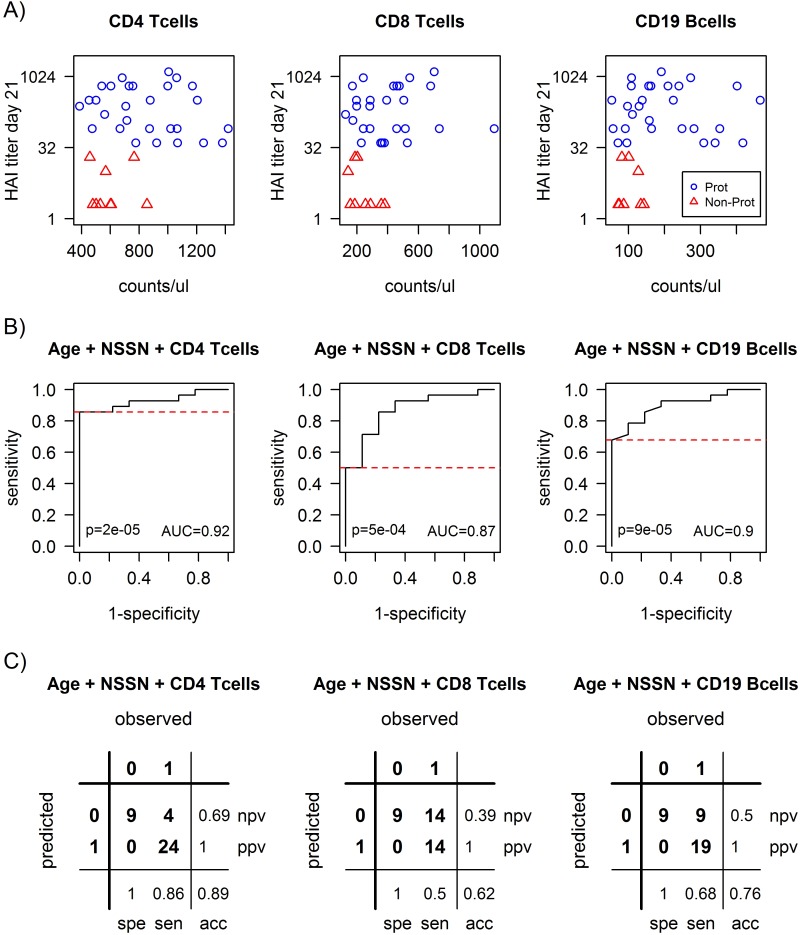
Prediction of serological response to A(H1N1)pdm09 as function of counts of major lymphocyte sub-populations in the pilot study.A) H1N1 sero-negative individuals that were sero-protected (blue circles) to H1N1 at day 21 post-vaccination had higher counts of CD4+ T cells, CD8+ T cells or B cells (CD19) at baseline as compared to non-protected individuals (red triangles, P<0.05). However, there is no continuous correlation between the various cell counts and the HAI titer. B) Logistic regression shows that a model combining baseline CD4+ T cell counts with age and NSSN, is the best predictor of sero-protection, with a high ROC-AUC = 0.92 and significant p-value = 0.00002. Similar models for CD8+ T cells or B cells (CD19+) give reasonable albeit lower prediction values. C) The combination of CD4+ T cell counts, NSSN and age gives a highly accurate 89% prediction of non-protection (when selecting for a specificity = 100%, or positive predictive value ppv = 100%, in order to capture all non-responders), with a sensitivity of sen = 86% and negative predictive value npv = 69%. The other lymphocyte sub-populations counts give less accurate predictions.